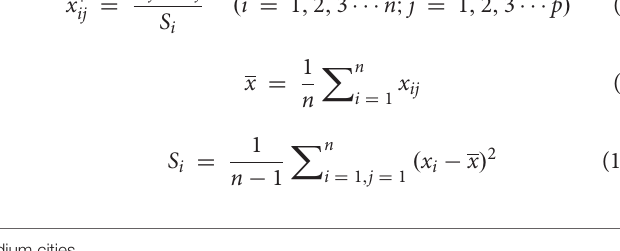
TABLE 1 | Evaluation index system of social development level of 35 large and medium